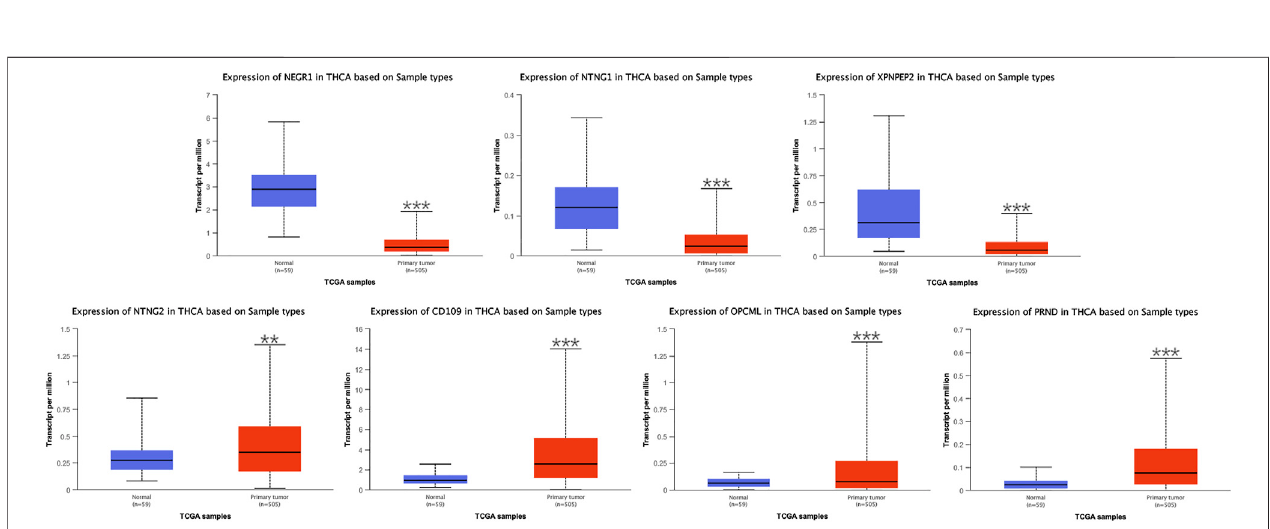
FIGURE 5 | Differential expression of NEGR1 , NTNG1 , XPNPEP2 , NTNG2 , CD109 , OPCML , and PRND based on UALCAN ( p p < 0.05, pp p < 0.01, and ppp p < 0.001).